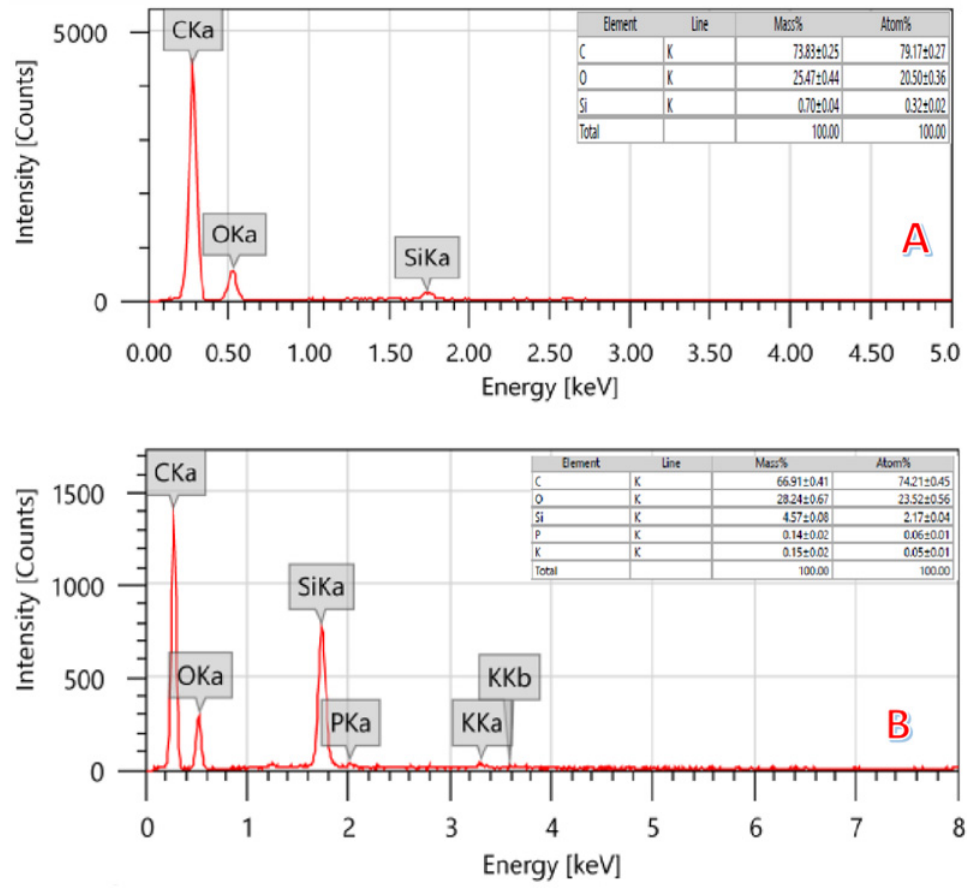
Figure 4. EDS of activated ( A ) (by 14 mL H 3 PO 4 -KOH solution) and pristine ( B ) carbon obtained from graphitization of the rice husk.